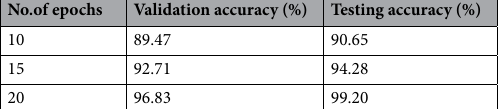
Table 2. Accuracy for lung infection segmentation with different